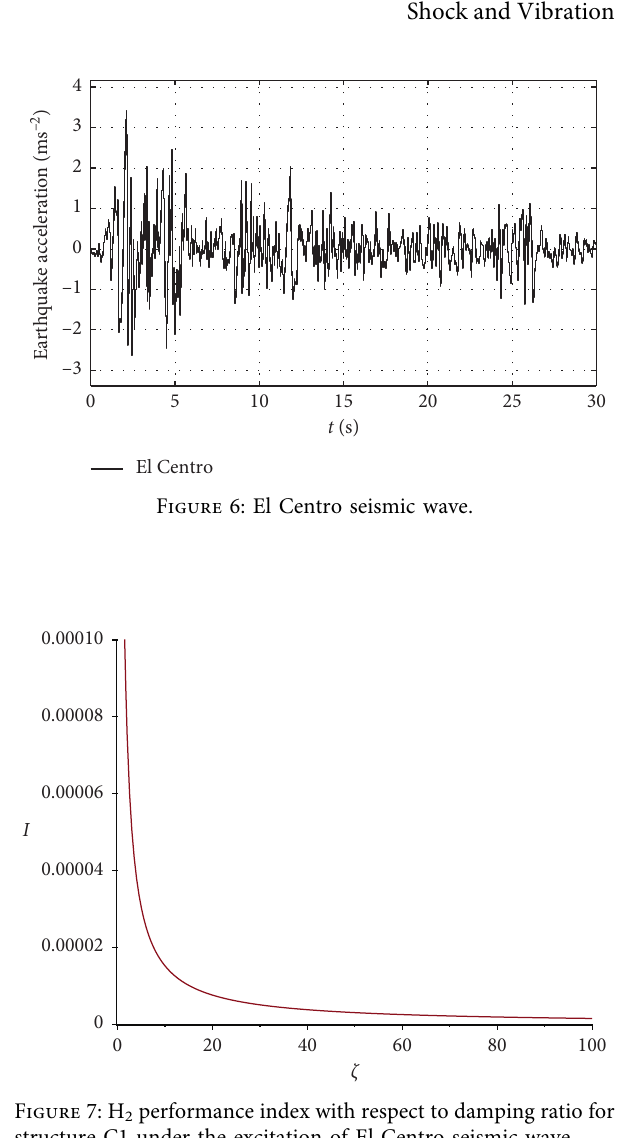
Figure 7: H 2 performance index with respect to damping ratio for structure C1 under the excitation of El Centro seismic wave.